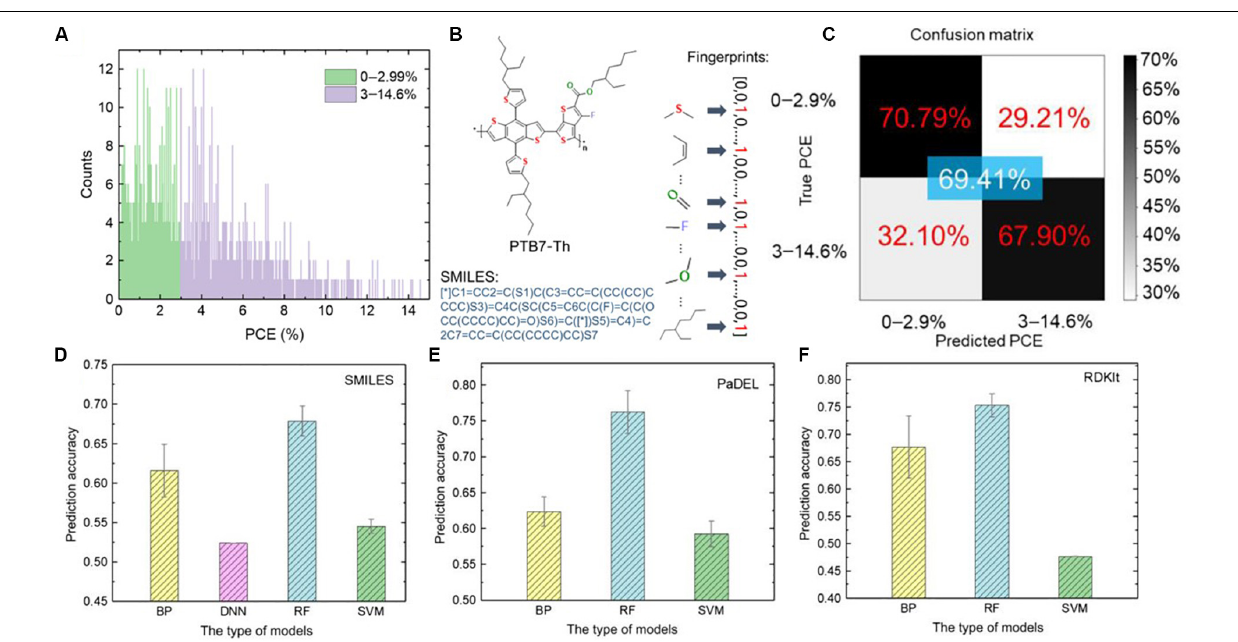
FIGURE 4 | (A) Distribution of PCE molecules in the database. (B) Schematic representation of molecules. (C) Testing of the deep learning model using images as input. (D–F) Testing results of different ML models using descriptors as input. Reproduced from Sun et al. (2019) with permission from Copyright Scientific